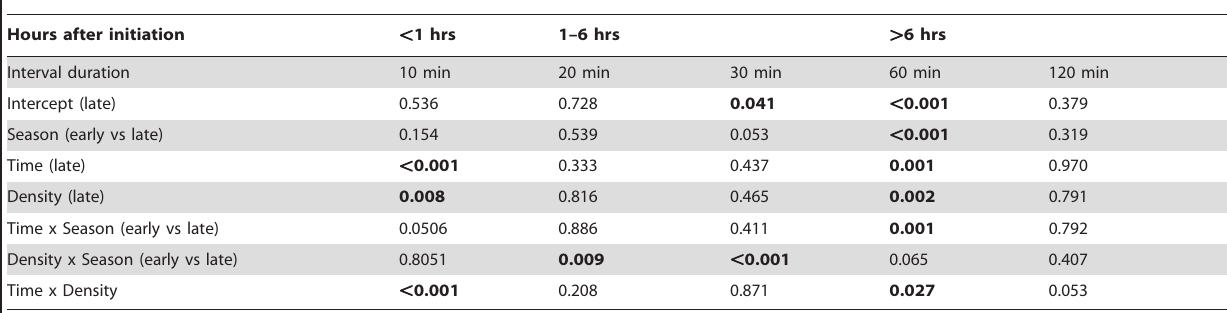
Table 2. GLMM models of recruitment in the lab.